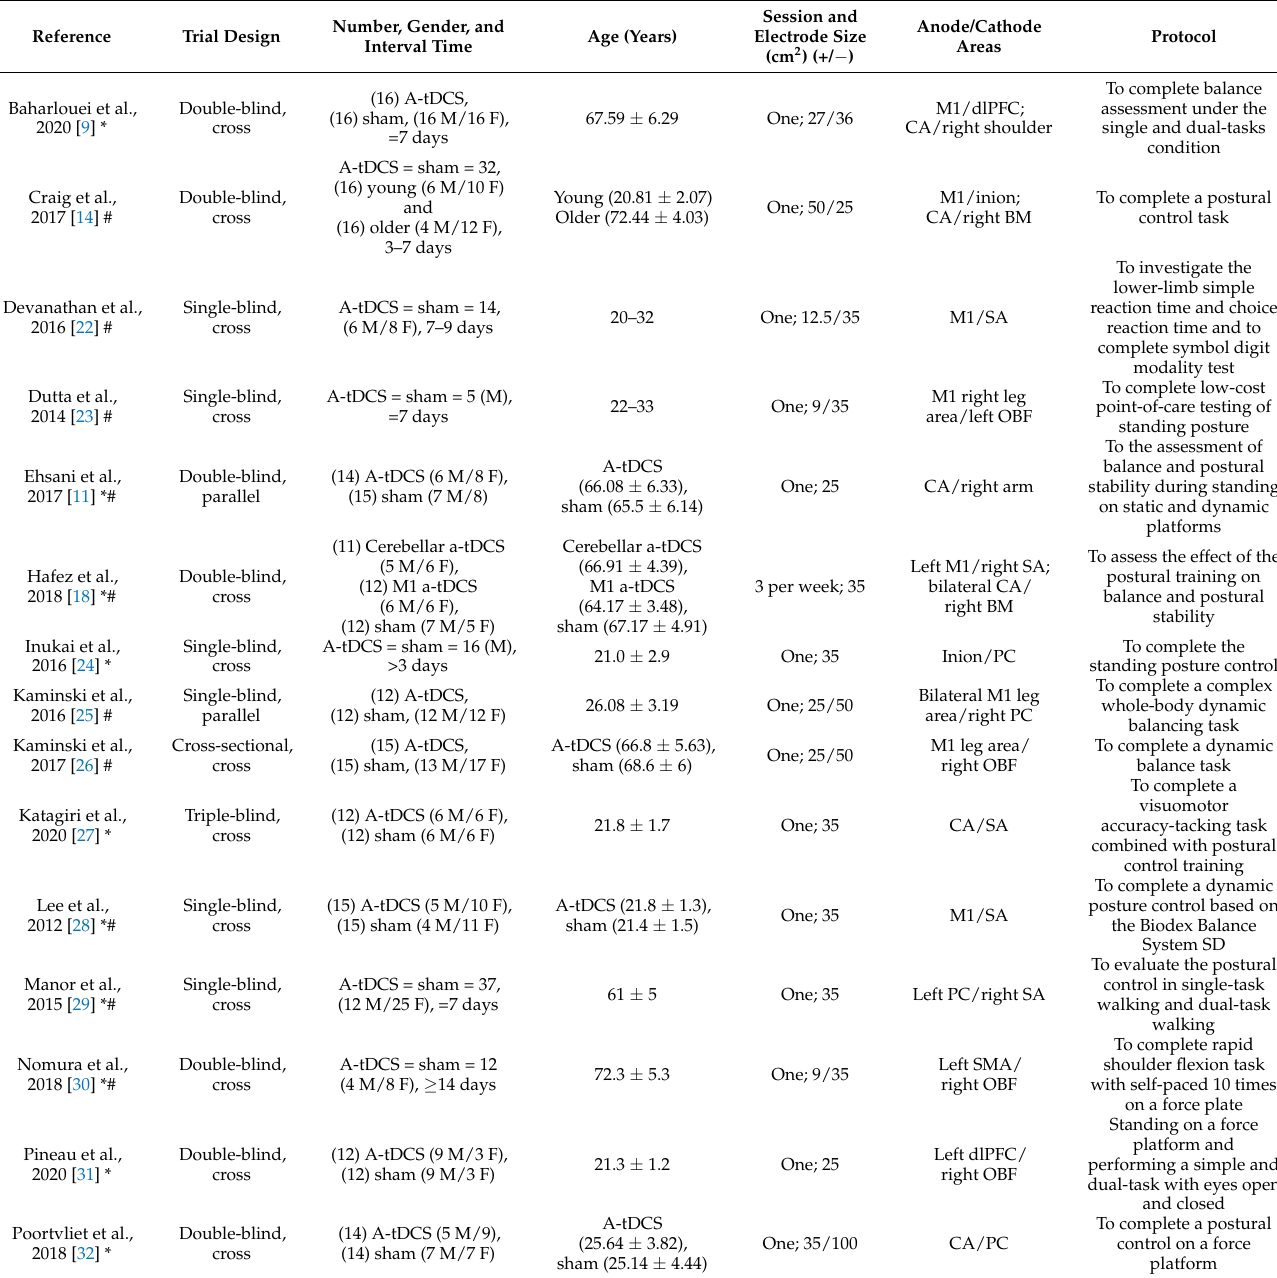
Table 1. Characteristics of the included